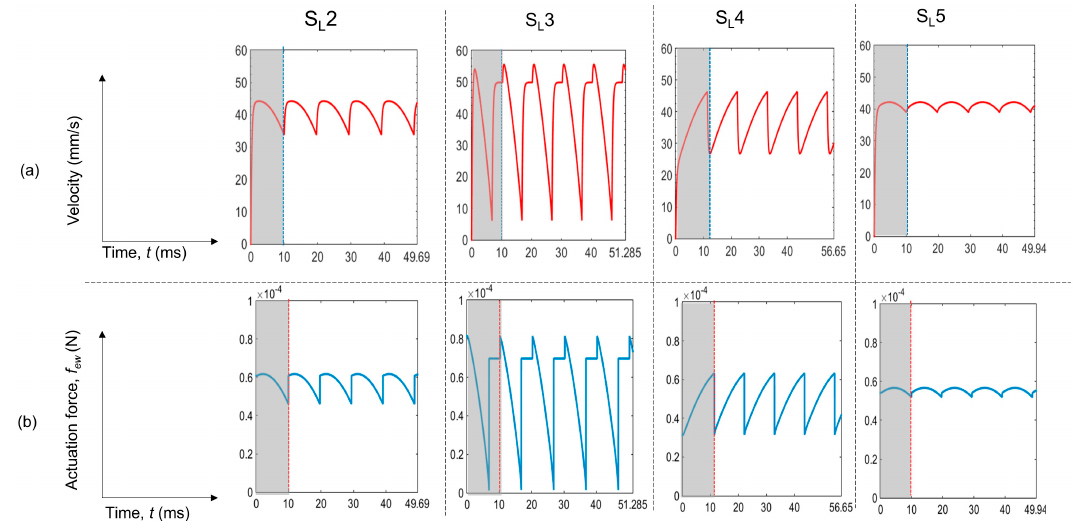
Figure 8. Theoretical ( a ) velocity profiles and ( b ) actuation force vs. time, for all of the cases of slender electrodes during the transition over a 2-mm distance. The shaded regions correspond to one switching period for each case.